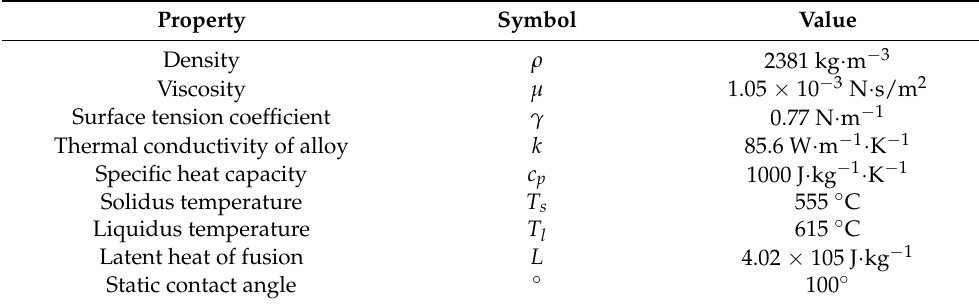
Table 1. Physical properties of Aluminum droplet used in the current model.